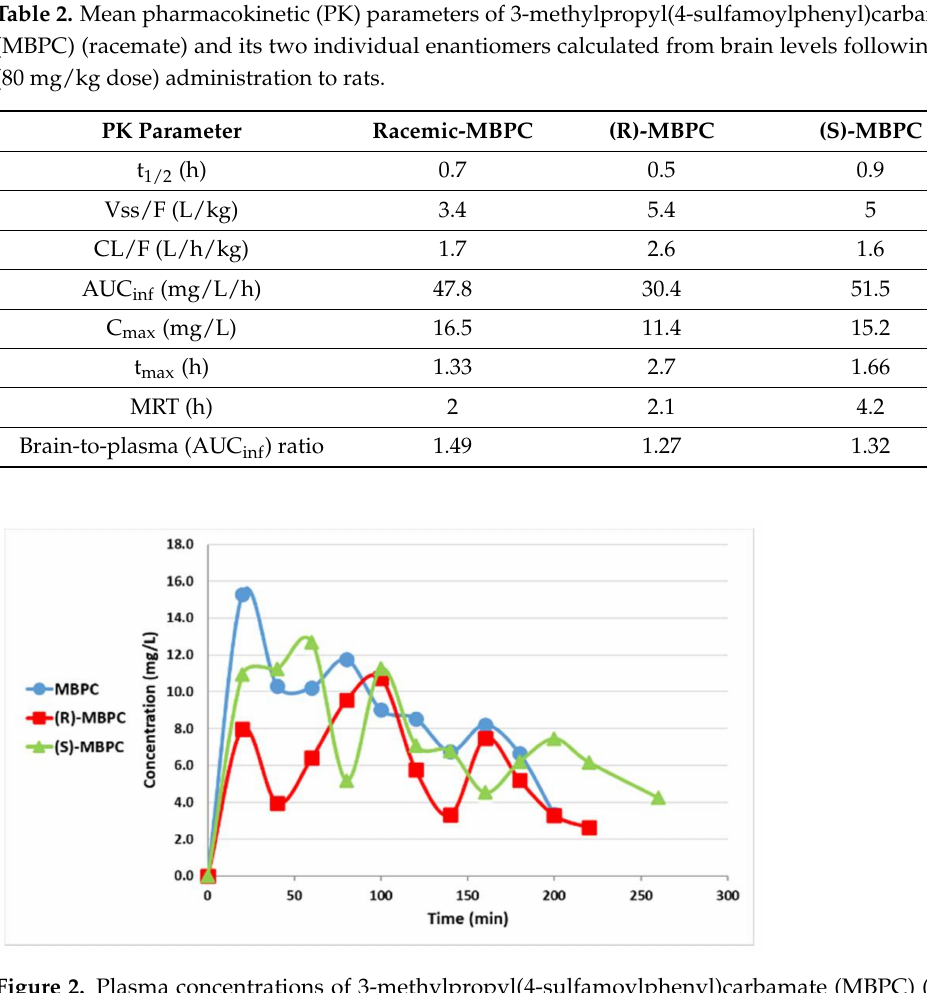
Figure 2. Plasma concentrations of 3-methylpropyl(4-sulfamoylphenyl)carbamate (MBPC) (race- mate), (R)-MBPC, and (S)-MBPC after i.p. (80 mg/kg) administration to